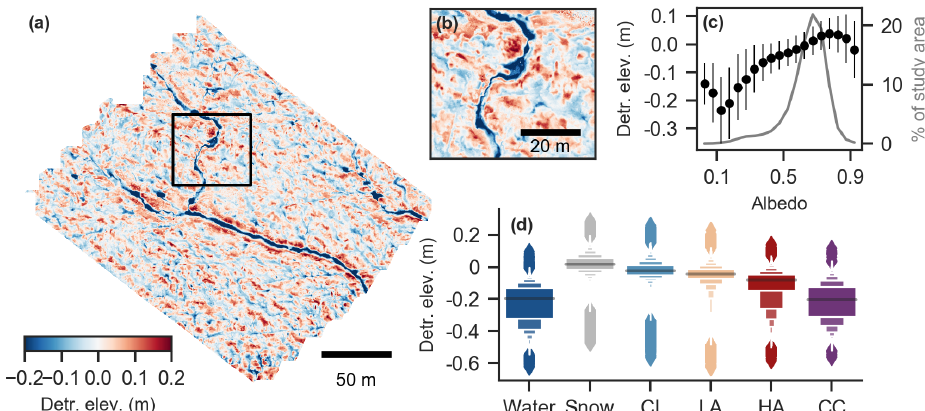
Figure 2. Surface topography variability at UPE. (a) Detrended elevation (“roughness”). Black box delineates the area shown in panel (b) . (b) Zoomed detail of detrended elevation, showing incised supraglacial stream and the pattern of local topographic highs and lows. (c) Median detrended elevation in each 5% albedo bin ± 1 σ (left axis) and percentage coverage of each albedo bin (gray line; right axis). (d) Letter plots of detrended elevation for each surface type, illustrating median (black line), distribution of elevation values (boxes) and outliers (diamonds) within each category (Hofmann et al., 2011), computed from whole area shown in (a)